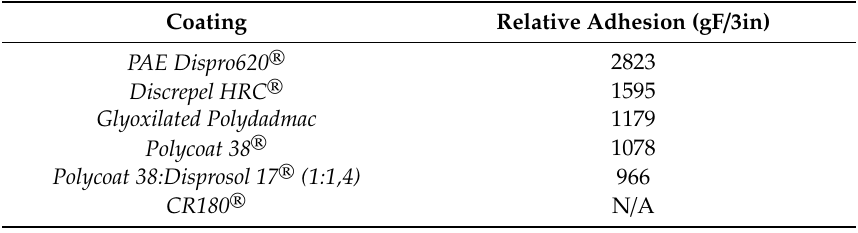
Table 1. Relative adhesion of di ff erent coatings commercially